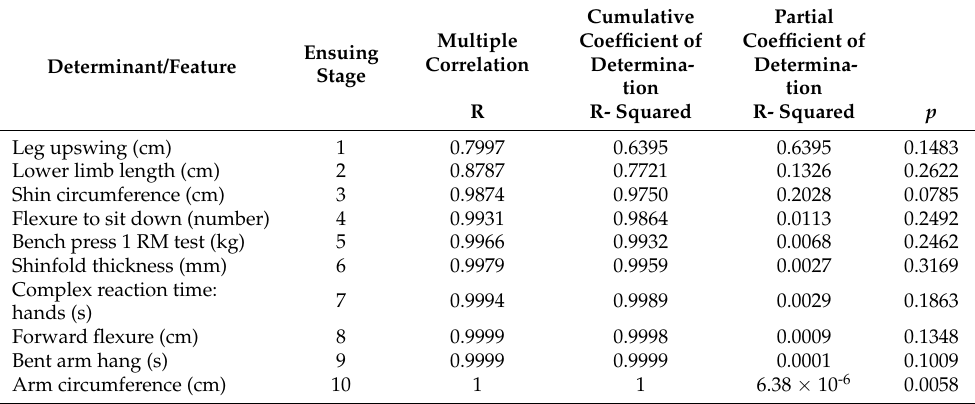
Table 6. Summary regression details from the 1st study stage for male participants; dependent variable = ranking